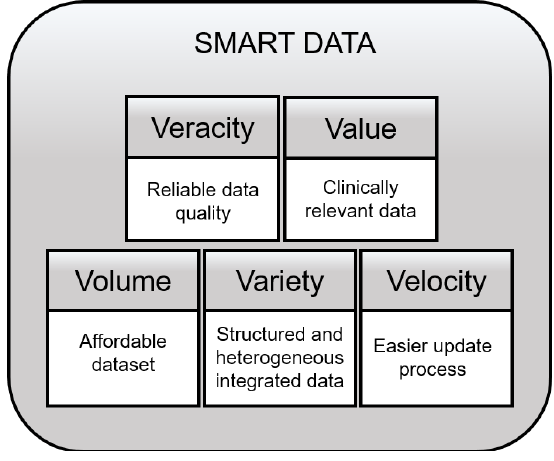
Figure 3. The 5 Vs of the Smart Data